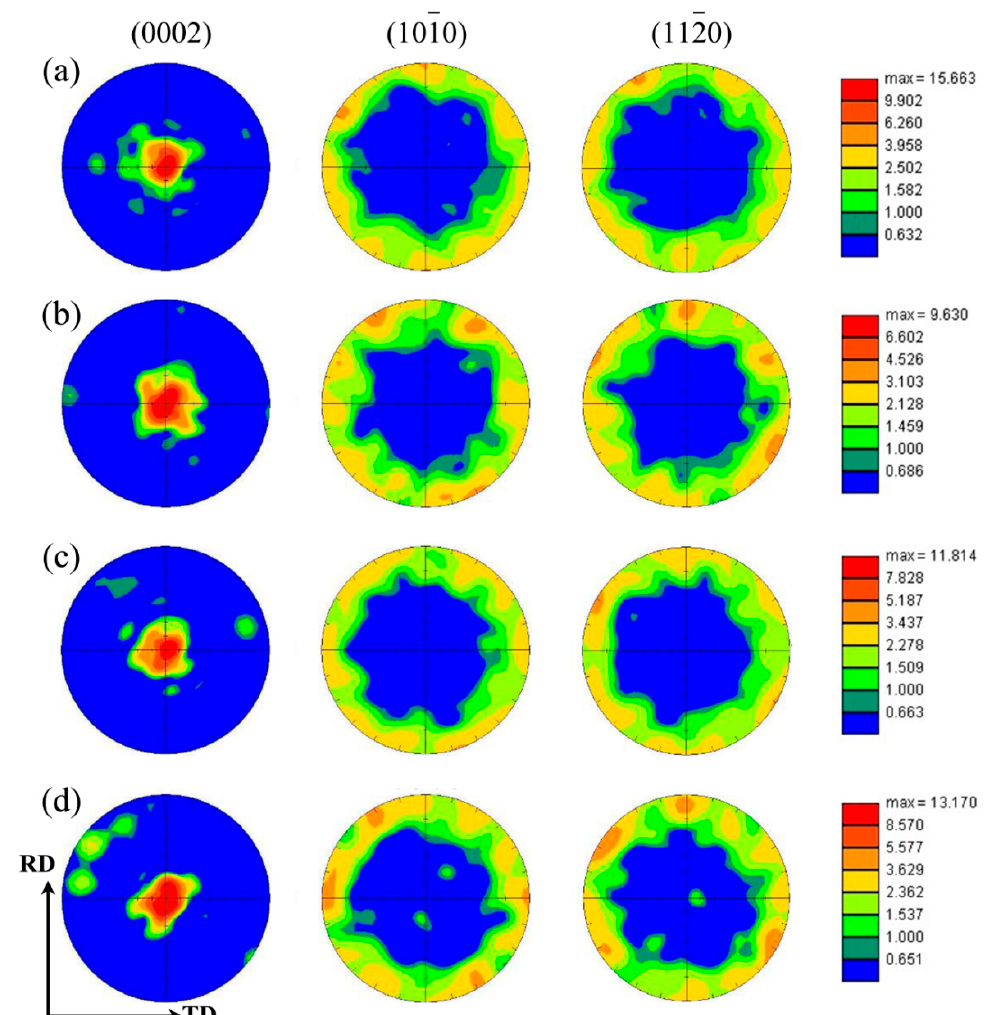
Figure 7. (0002), (10-10), and (11-20) pole figures of AZ31 magnesium alloy sheets for ( a ) 400 °C— 20%, ( b ) 400 °C—30%, ( c ) 400 °C—40%, and ( d ) 400 °C—50% (RD: rolling direction, TD: transverse